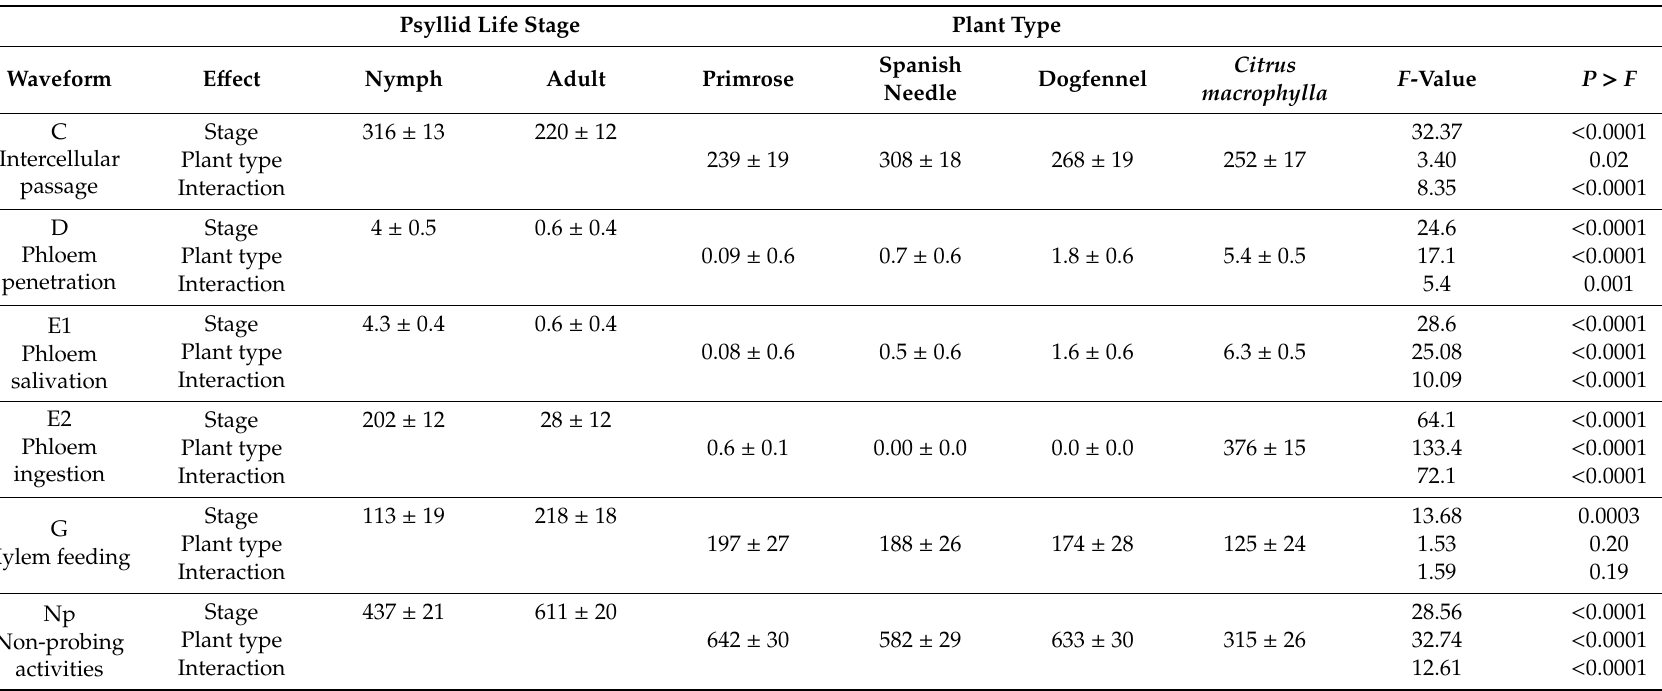
Table 3. Mean ( ± SEM) total duration (frequency x mean duration) (mins) of feeding activities by Diaphorina citri adults and nymphs on weed species and C . macrophylla during 18 h EPG recordings. Number of replicates: Primrose n = 18, Spanish needle n = 22, Dogfennel n = 18, and C. macrophylla n =